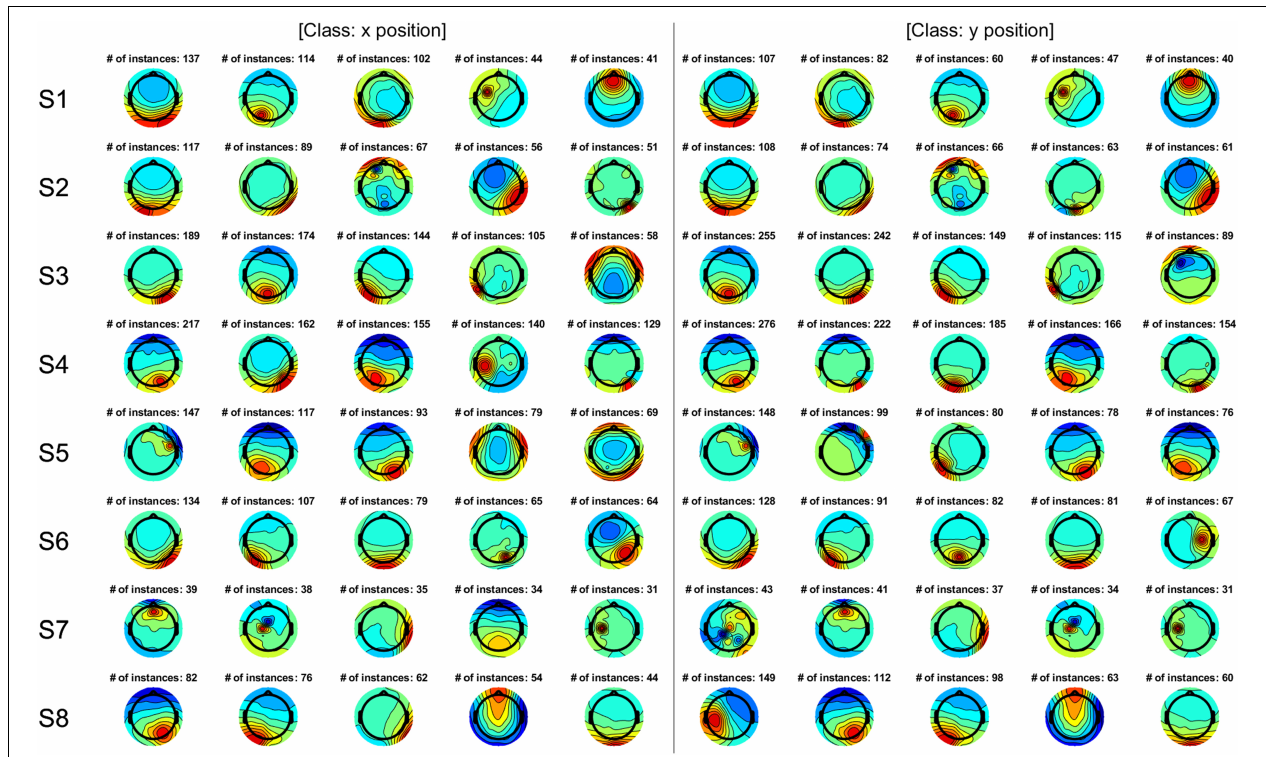
FIGURE 11 | The five most frequently utilized ICs in all classifications for x and y positions. The number indicates the number of times the IC was used in all classifications. ICs were sorted according to the number of